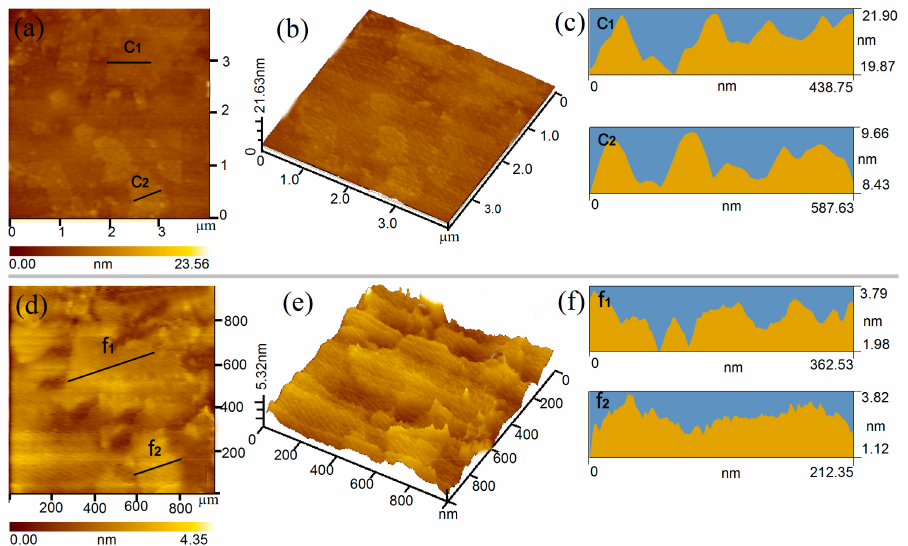
Figure 2. Atomic force microscopy (AFM) images of GO nanosheets: ( a ) from original GO nanosheets; ( b ) three-dimensional images; ( c ) profile images; ( d ) from carboxymethyl chitosan (CCS)/GO intercalation composites; ( e ) three-dimensional images and ( f ) profile